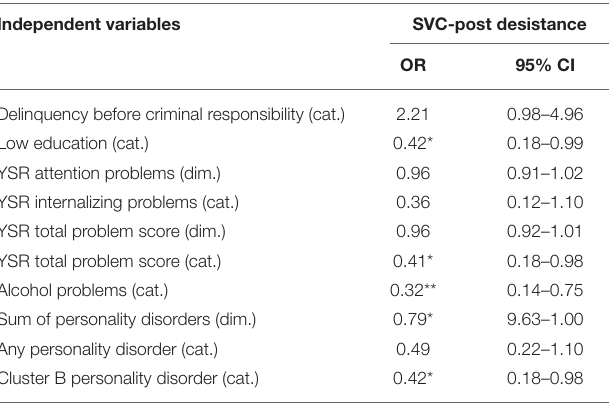
TABLE 3 | Binary regression analyses on SVC-post offender status (single predictors). Independent